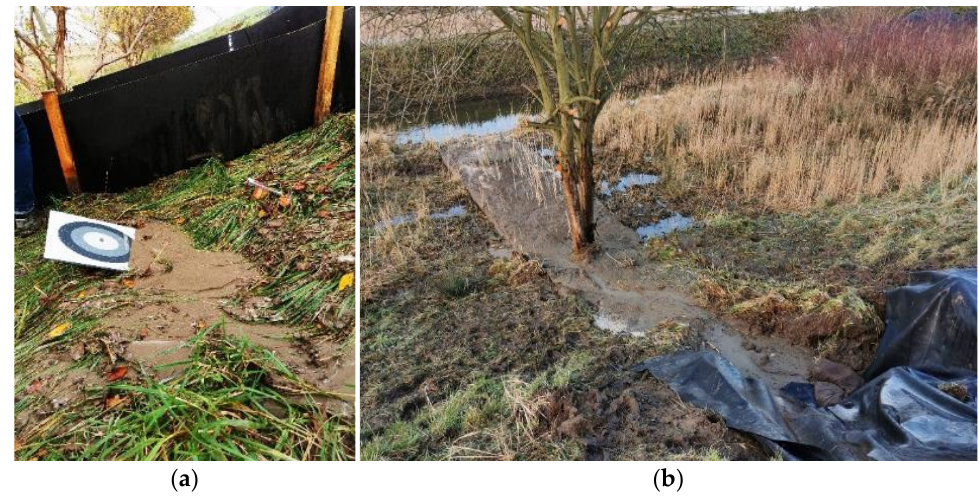
Figure 9. The role of burrows and the outcome of dike cover collapse at the second test with a tree: ( a ) puddle of sand flowing out at burrows near the dike toe; ( b ) the aftermath of a collapsed dike slope after sand outflow at the toe. Note that the tree itself is in place and did not appear to influence the process.